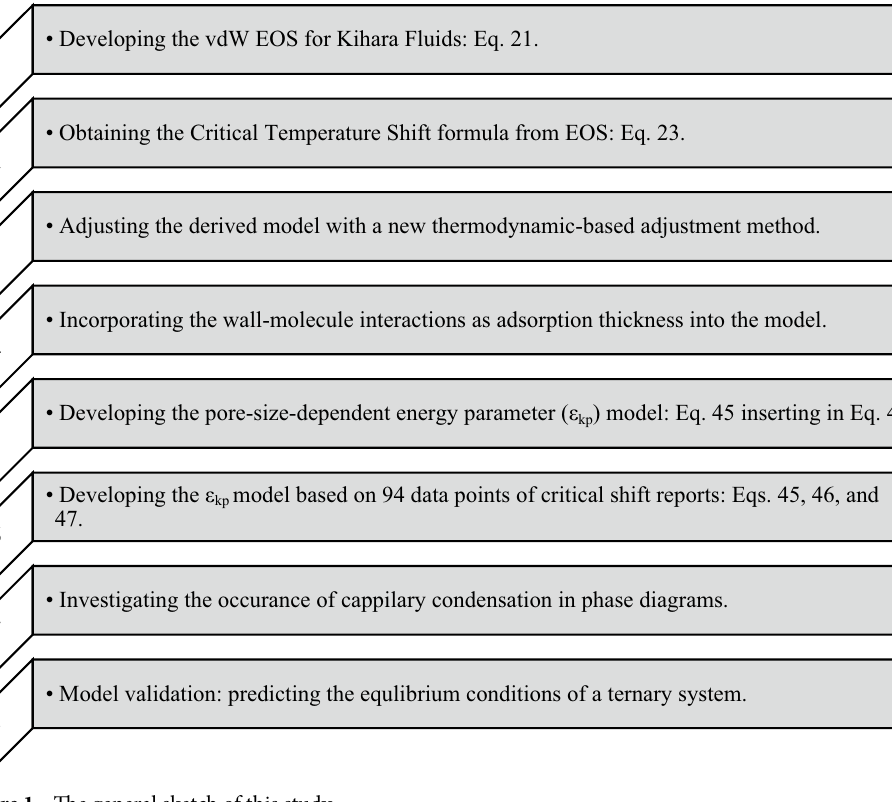
Figure 1. The general sketch of this